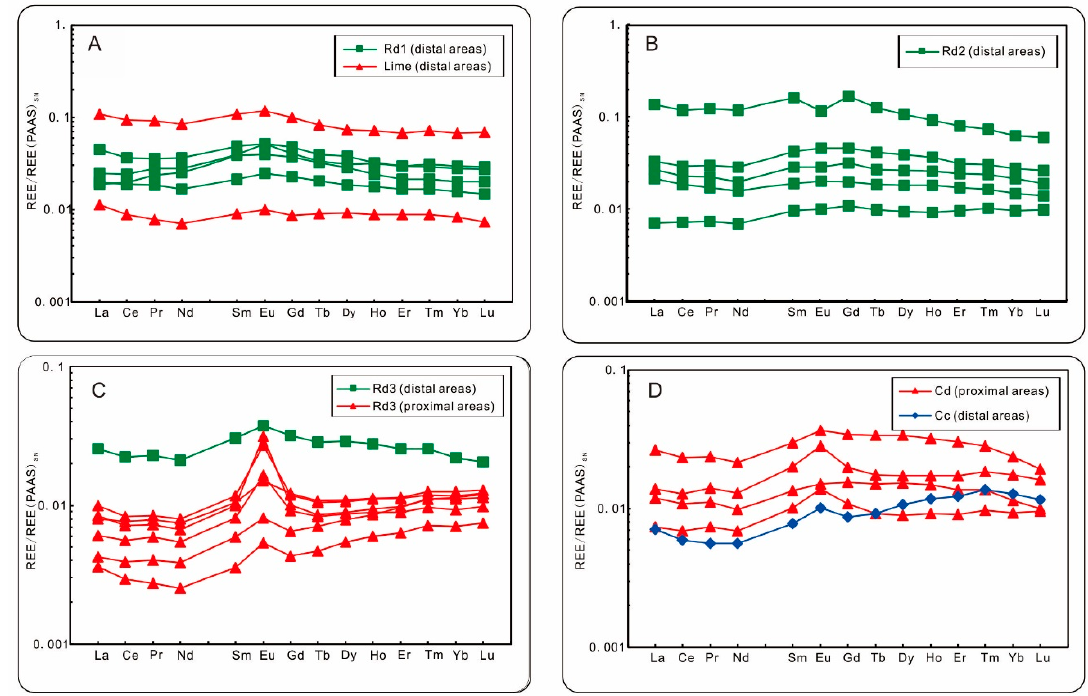
Figure 15. Post-Archean average shale (PAAS)-normalized rare earth element (REE) patterns of limestone and dolomites. The PAAS data were obtained from McLennan (1989) [35].